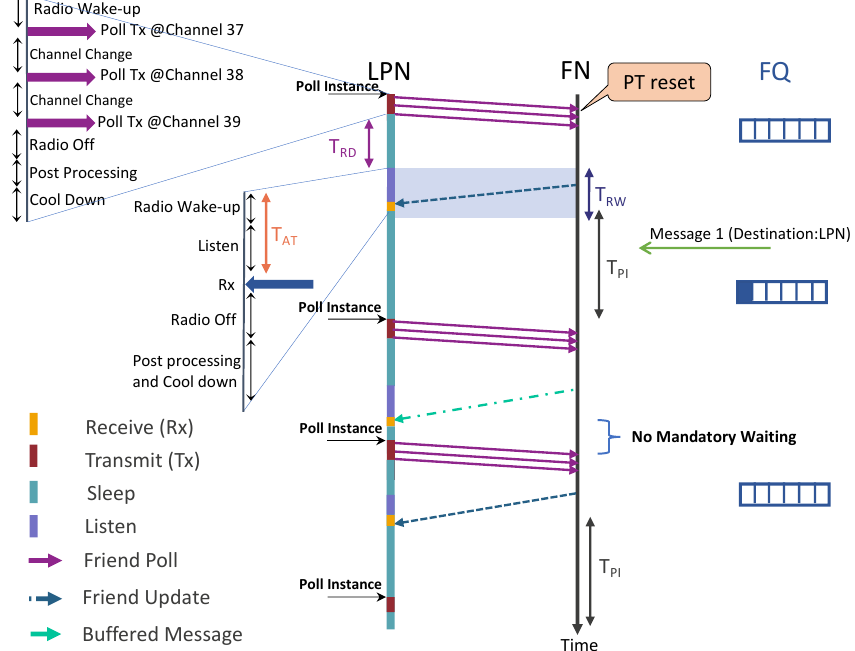
Figure 3. Sequence diagram of the messages exchanged between the LPN and FN to receive DL